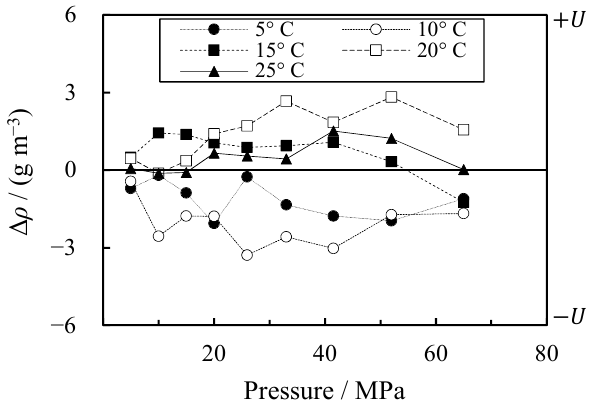
Figure 10. Deviation of measured from predicted seawater densities (cid:49)ρ in the interpolation region at salinity 2. U – uncertainty in the density–salinity